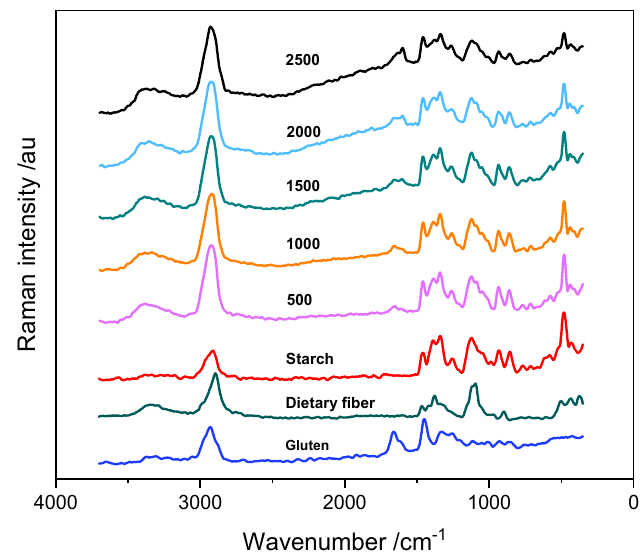
Foods 2018 , 7 , x FOR PEER REVIEW Figure 1. Raman spectra of various flour types and their selected components. Figure 1. Raman spectra of various flour types and their selected components.